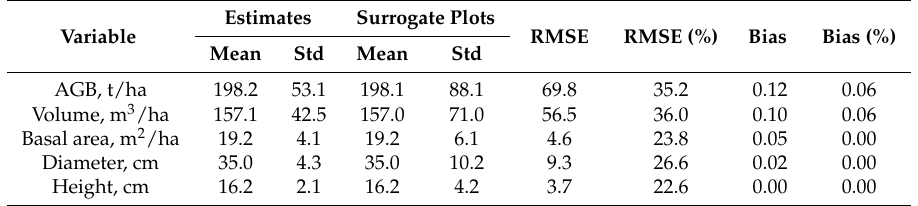
Table 9. Error statistics for the LAMP3 estimates before histogram matching, when compared to LiDAR predictions, on 9805 surrogate plots of 1-hectare size each.